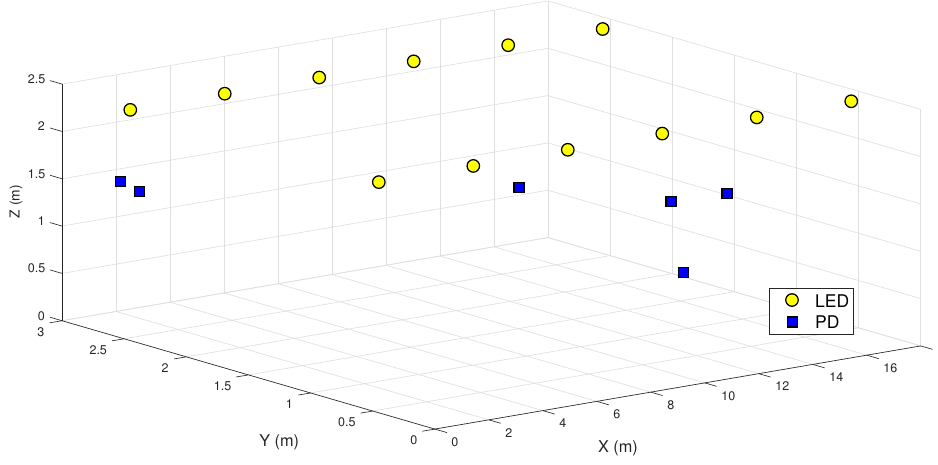
Figure 5. Distribution of LEDs and PDs in a 3D